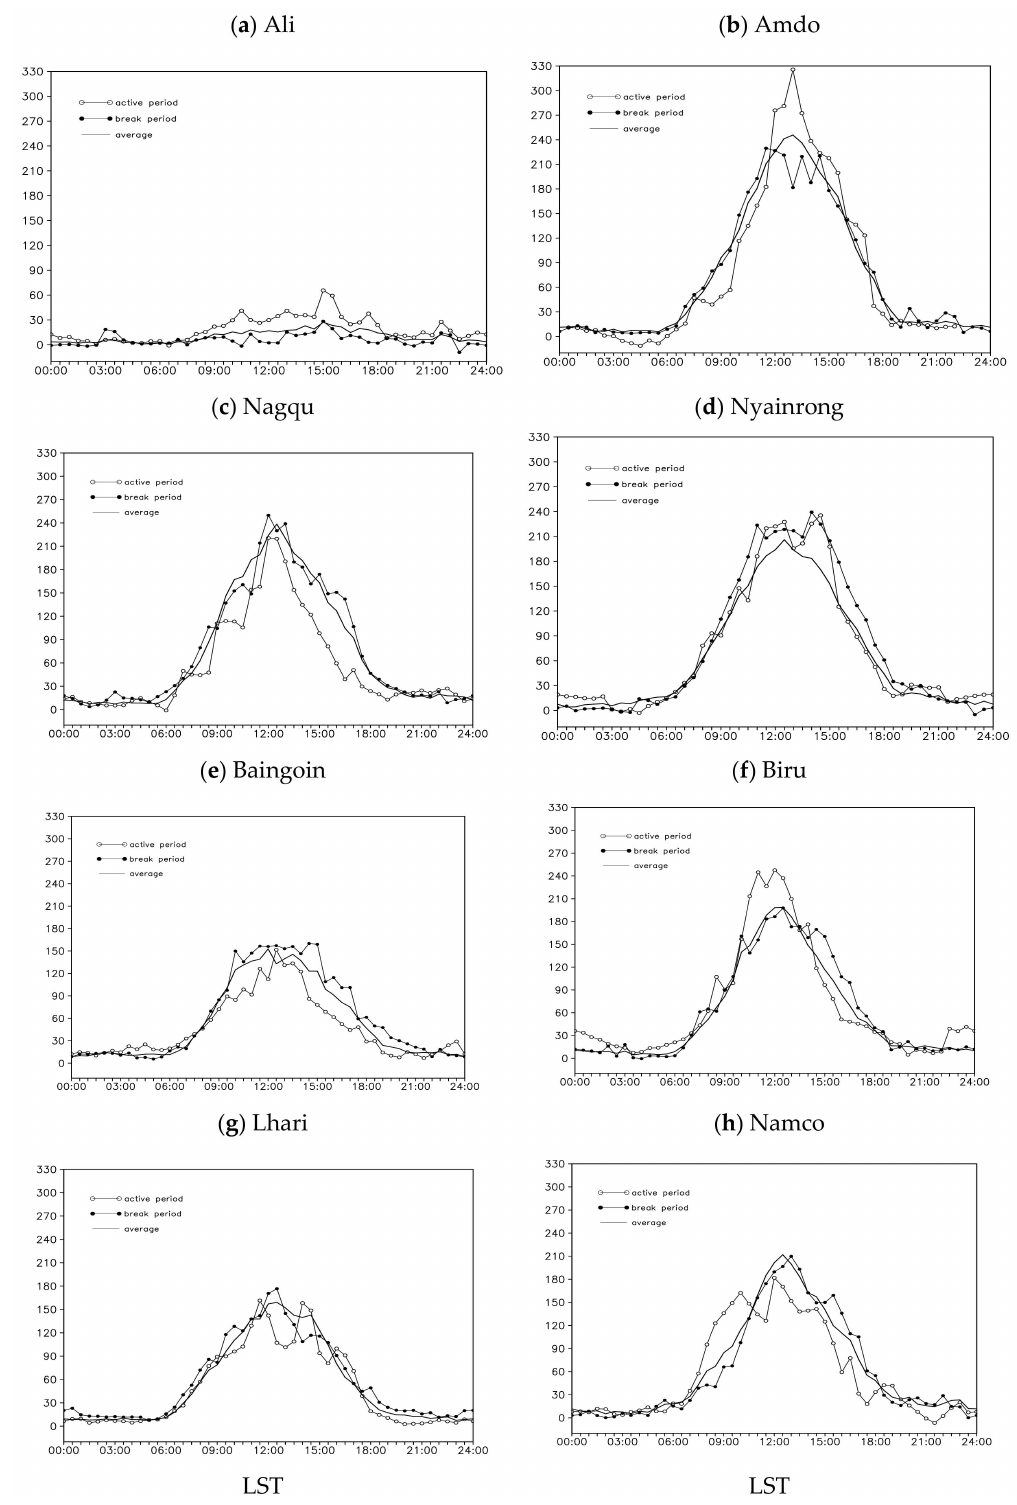
Figure 8. Same as Figure 7, but for latent heat flux (LH) (units: Wm − 2